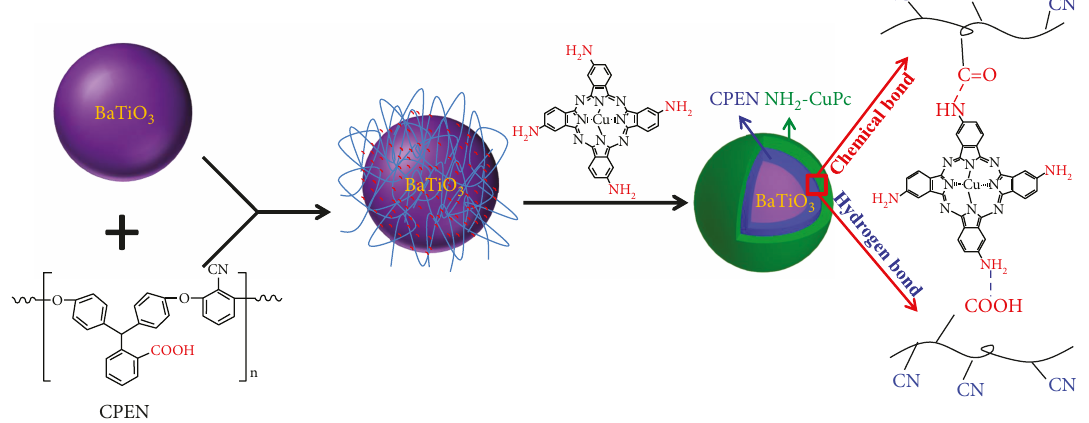
Figure 6: Synthetic route for the core-shell-shell-structured